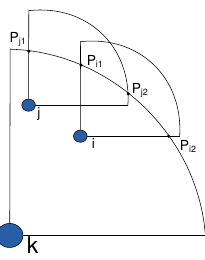
Figure 4. Border area coverage